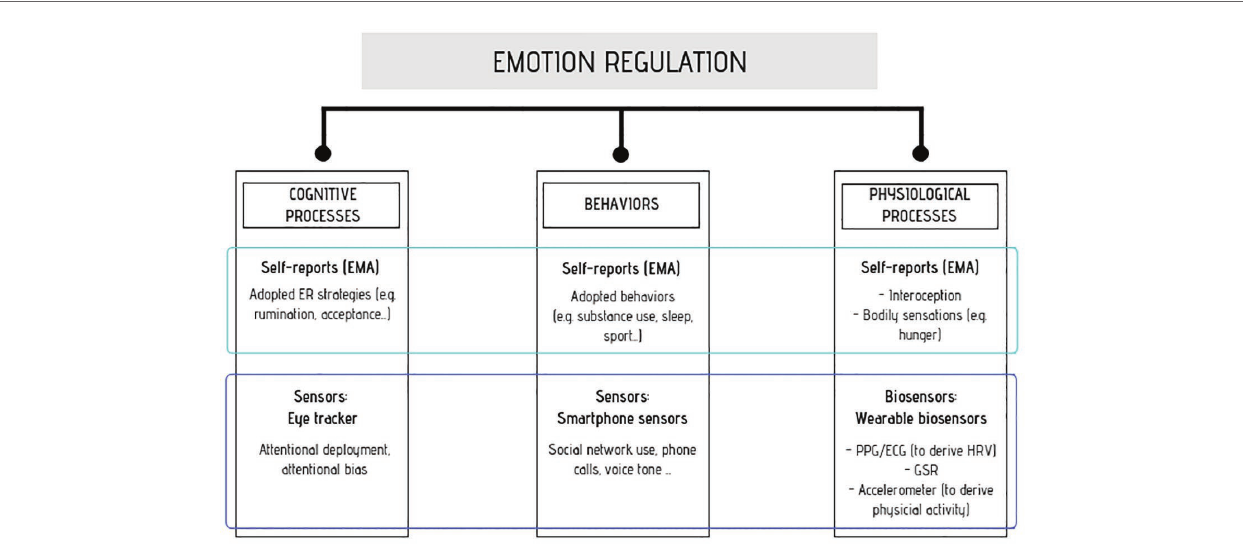
FIGURE 1 | ER is composed of different facets: Cognitive mechanisms, behavioral aspects and physiological processes. The integration of different technologies could grasp all these facets, leading to a more comprehensive understanding of ER. On the one hand, the use of self-reports by means of EMA could assess the three dimensions, i.e., by asking people to report them on a mobile device. On the other hand, the use of embedded-sensors and biosensors could further increase the quantity and objectivity of this information. Cognitive processes, such as attentional deployment or attentional bias, could be investigated using an eye-tracker or other implicit measures like Go/No Go Tasks. Behaviours could be assessed using data gathered from embedded sensors, like number of calls/messages or use of social networks. Finally, the underlying physiological processes could be grasped thanks to wearable biosensors, such as wrist-watches that monitor HRV or GSR parameters. ER, emotion regulation; EMA, ecological momentary assessment; PPG, photoplethysmography; ECG, electrocardiogram; HRV, heart rate variability; GSR, galvanic skin